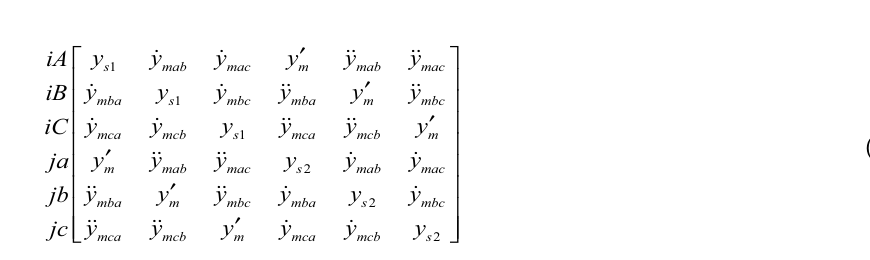
Fig. 7 Topology of the three-phase three-limb core transformer; the three-phase three-limb core transformer has asymmetric magnetic circuits. The topology shows the relationship between equivalent reactance and connection of the